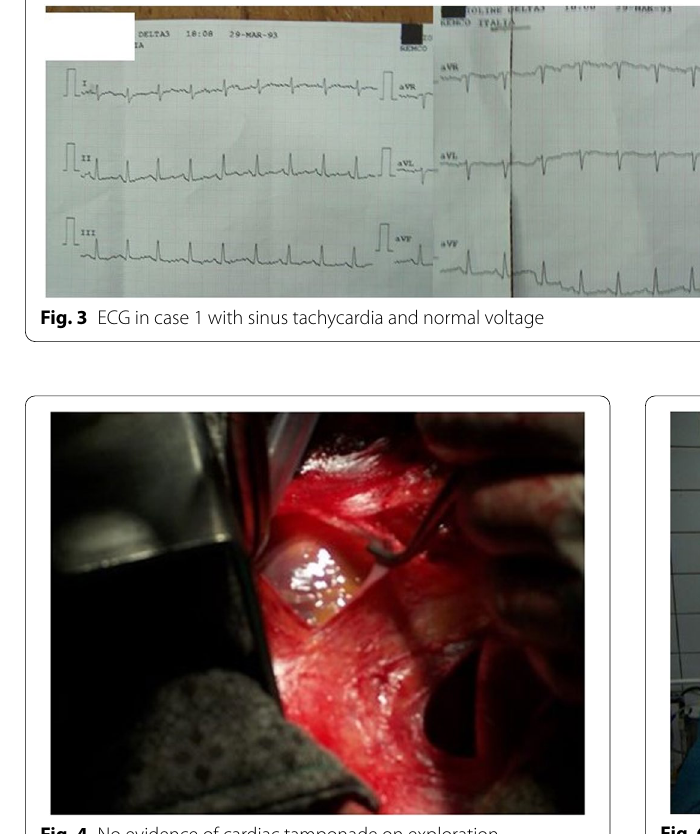
Fig. 4 No evidence of cardiac tamponade on exploration